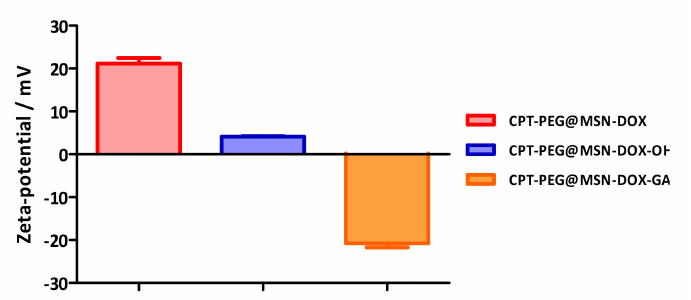
Figure 2. Zeta potential of CPT-PEG@MSN-DOX , CPT-PEG@MSN-DOX-OH , and CPT-PEG@ MSN-DOX-GA . Data represented as mean ± SD ( n = 3). Data measurements at pH =